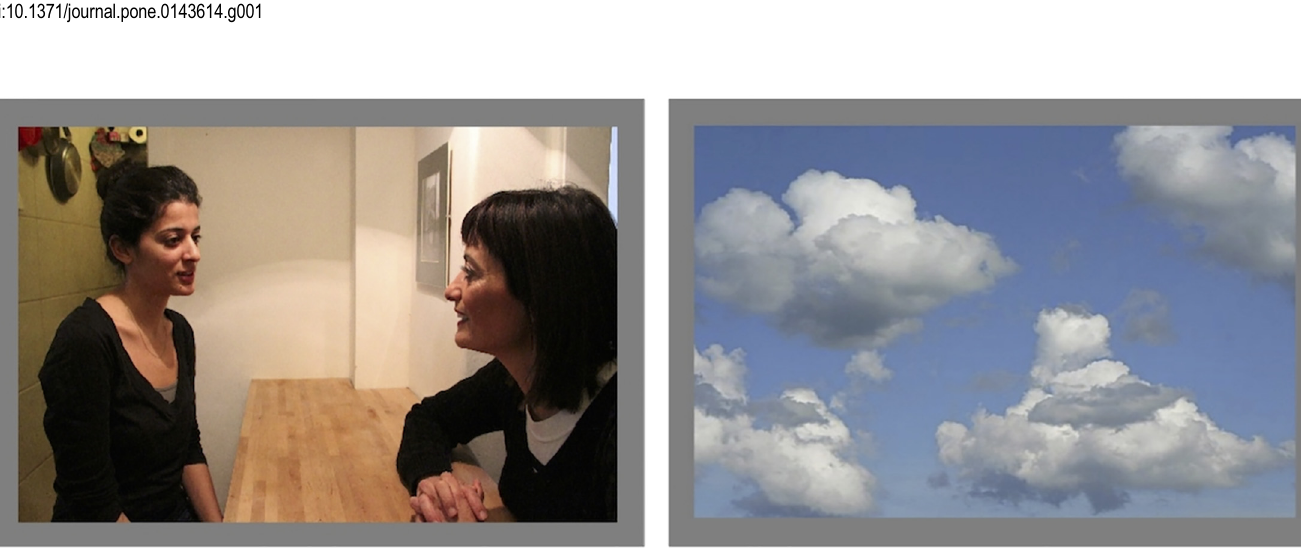
PLOS ONE | DOI:10.1371/journal.pone.0143614 November 25,